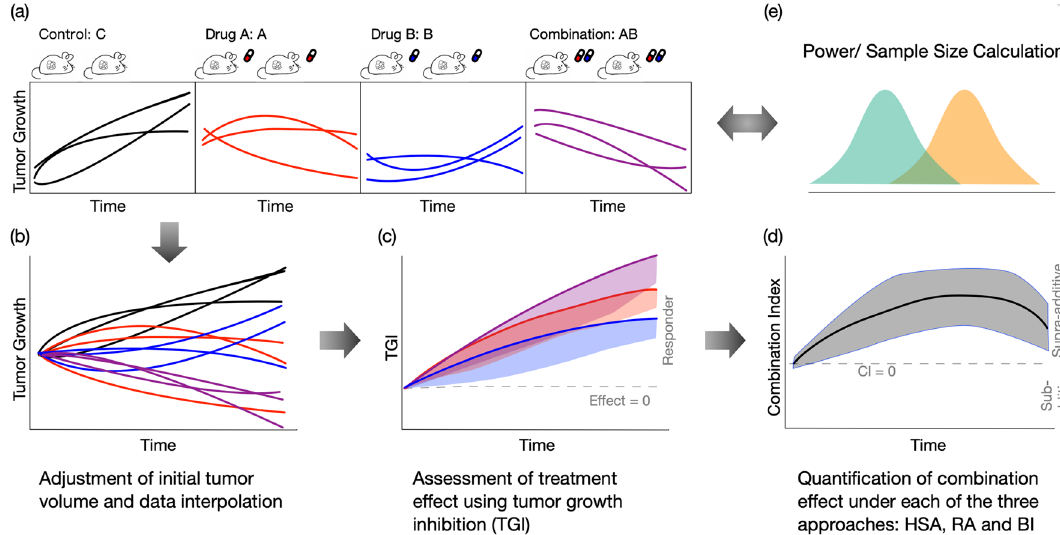
Figure 1. Overview of the analysis pipeline of combPDX. ( a ) Tumor volume measurements from four treatment arms (C, A, B, and AB) are collected from PDX experiments. ( b ) For an individual mouse, the response at each time point is determined by computing relative tumor volume to adjust for heterogeneous initial tumor measurements. ( c ) The drug effect for each treatment group (A, B, and AB) relative to the control group is quantified by tumor growth inhibition (TGI). ( d ) The combination effect under each reference model (HSA, RA, and BI) is assessed using a combination index. In addition, ( e ) sample size calculation and power analysis are